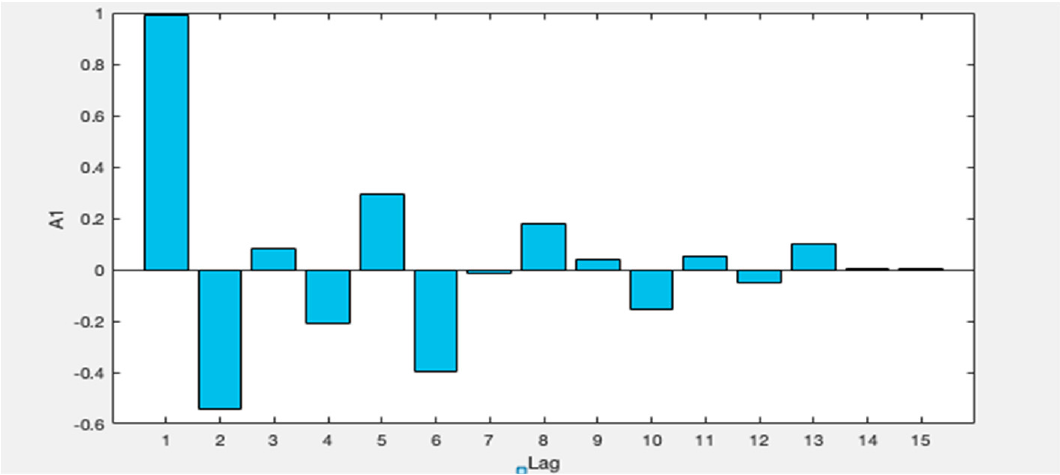
Figure 11. The partial auto correlation function (PACF) results of A1 by EWT of “Yangdong Line.”